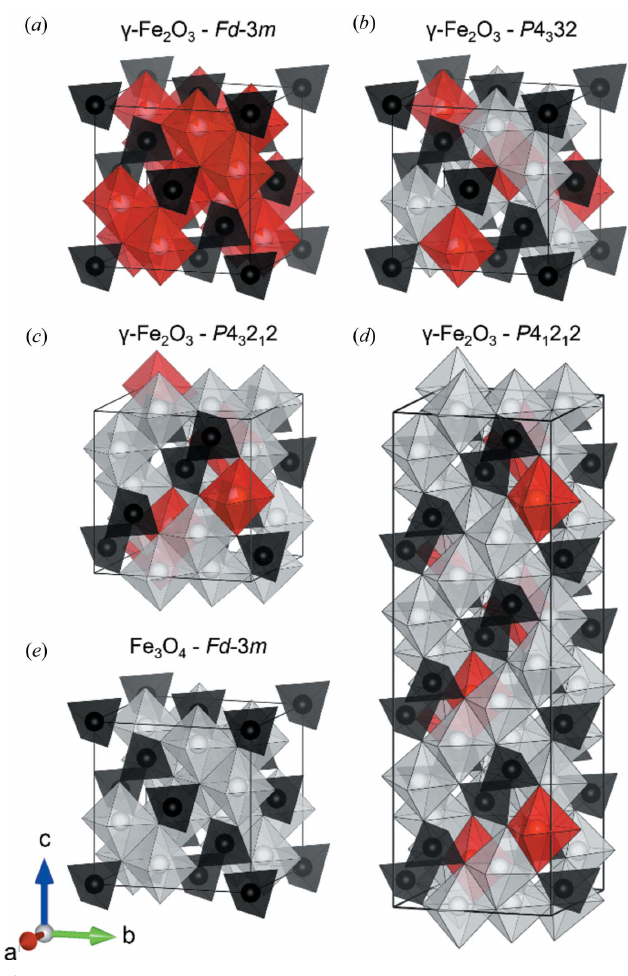
Figure 1 ( a )–( d ) Illustrations of the possible (cid:2) -Fe 2 O 3 structural configurations and ( e ) the structure of Fe 3 O 4 . The black and white polyhedra represent tetrahedral [FeO 4 ] and octahedral [FeO 6 ] units, respectively. The red polyhedra highlight the partially occupied or unoccupied octahedral sites, illustrating the degree of vacancy ordering. The illustrations have been made using the structure-visualization software VESTA (Momma & Izumi,